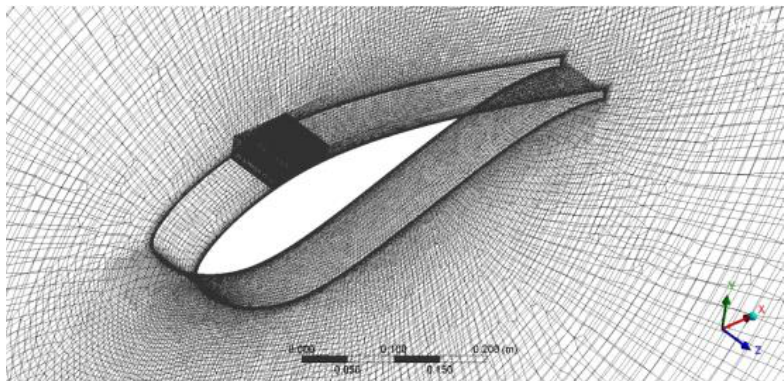
Figure 5. The grid generated for the whole domain